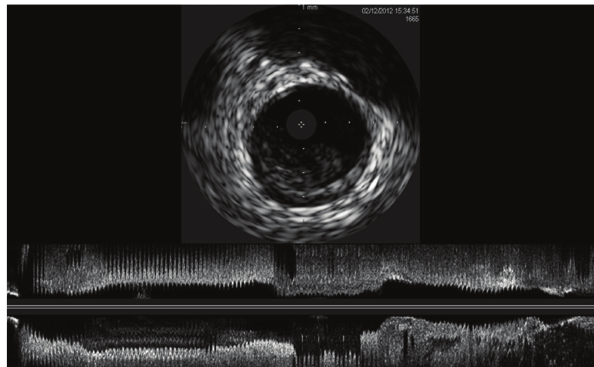
Figure 3: IVUS demonstrating significant residual thrombosis burden with LAD